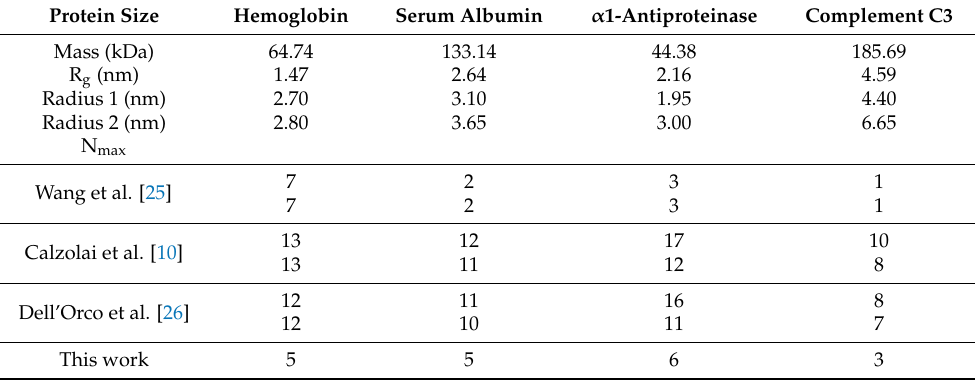
Table 3. In the first section, the mass, gyration radius, r g , and the smaller and bigger radius for each protein are recorded. In the second section, the maximum number of proteins that can absorb over the AuNP surface using different equations are